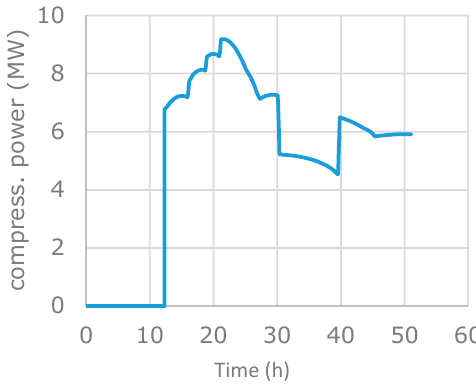
Figure 18. Compressor power (summer loading).